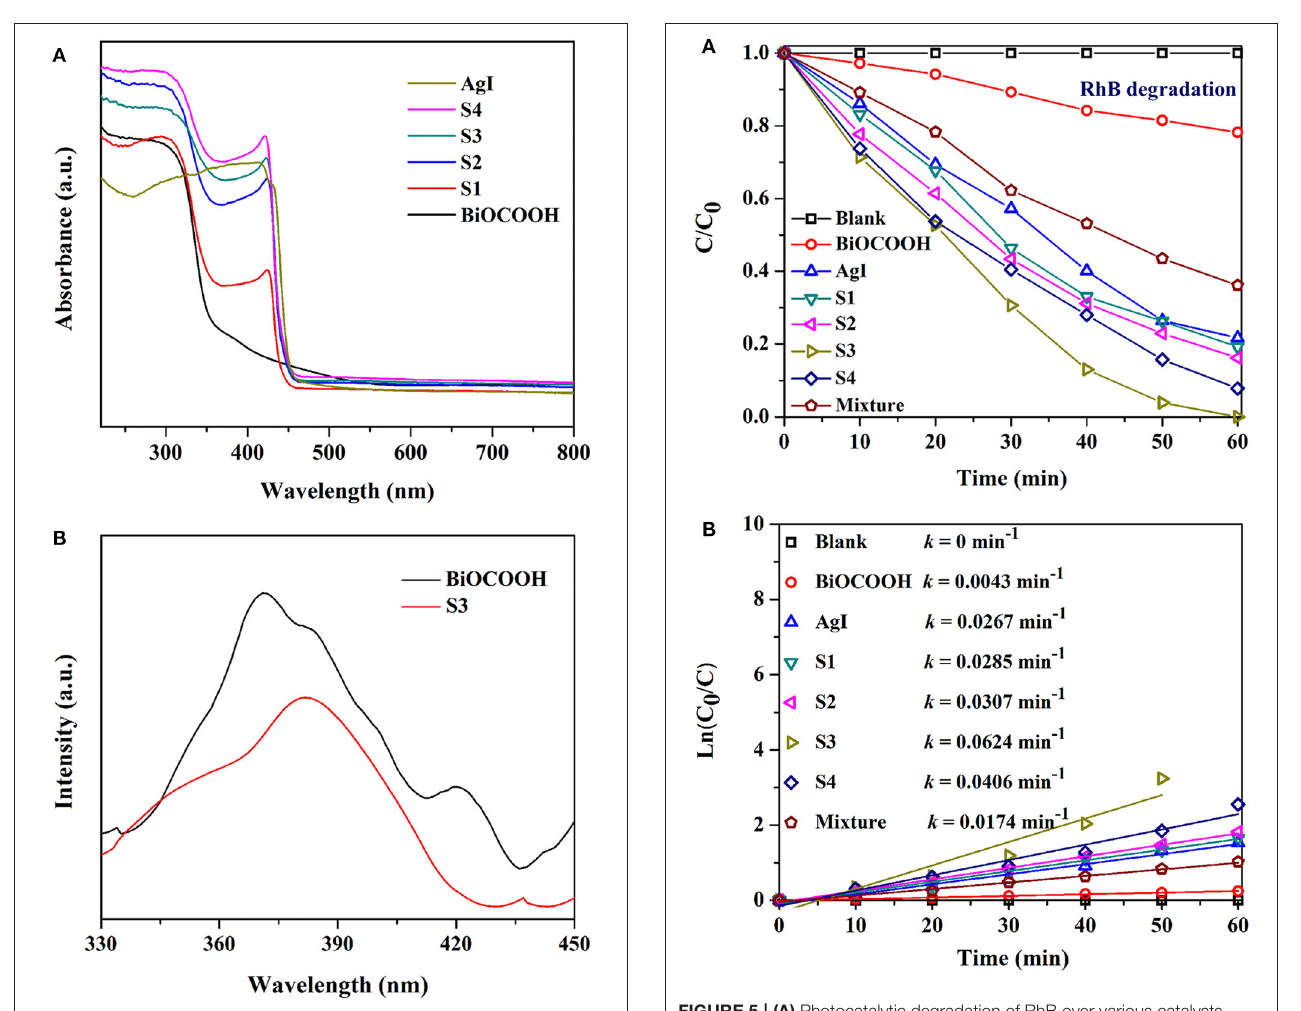
FIGURE 5 | (A) Photocatalytic degradation of RhB over various catalysts under visible light. (B) The kinetic curves over different